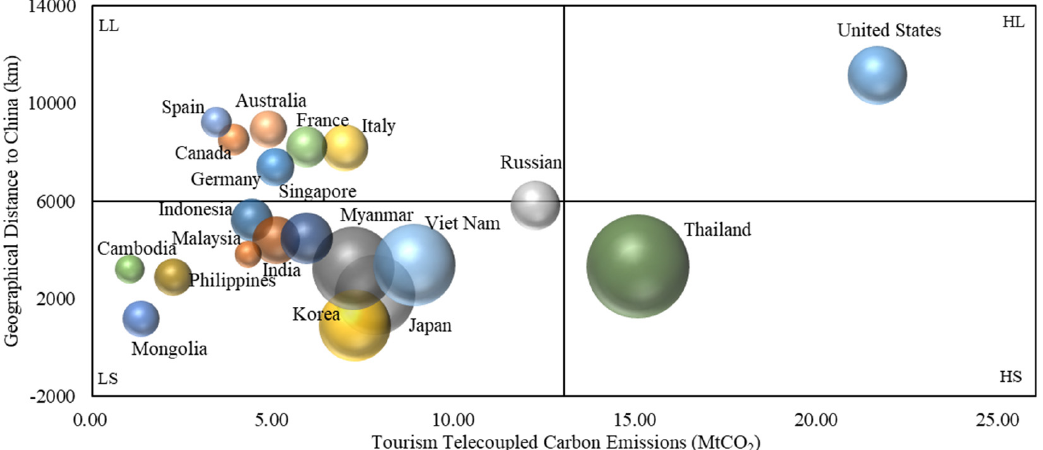
Figure 6. Geographical distance and carbon emissions of the tourism telecoupling system (20 main countries are shown).